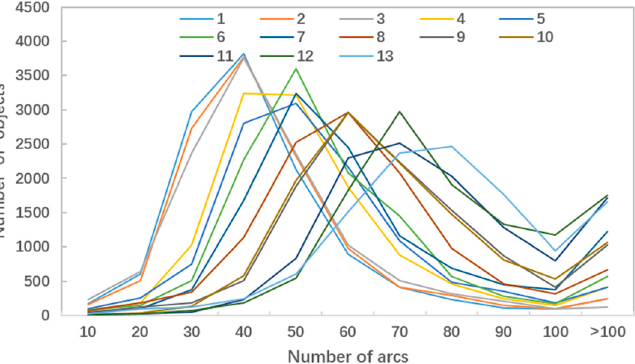
Figure 12. Variation of the number of objects observed using the different constellation configurations for the observation frequency.